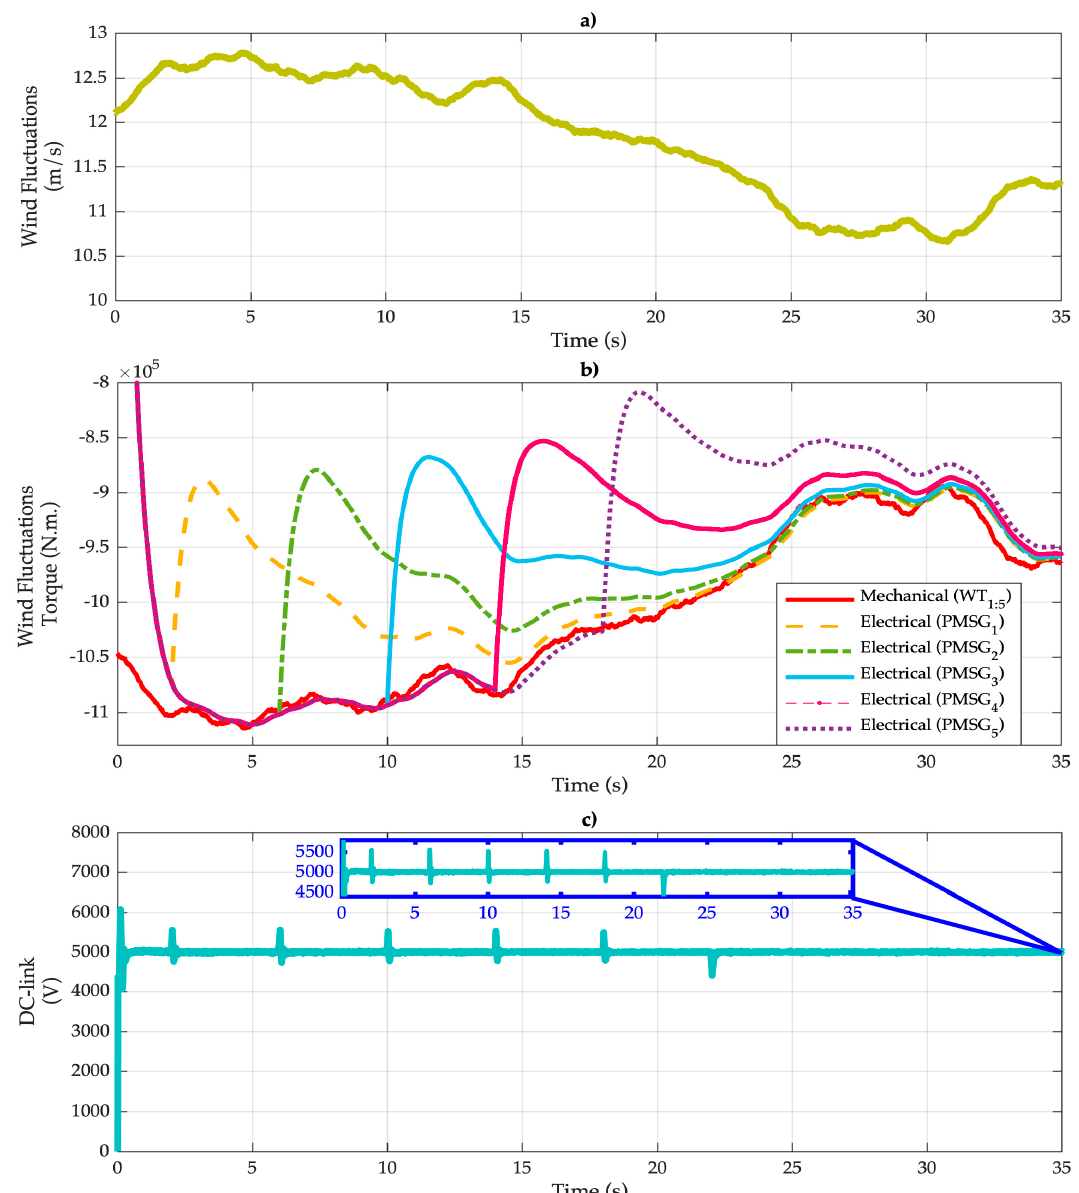
Figure 7. Behavior of parameters in the WECS in a closed loop. ( a ) Wind fluctuations; ( b ) mechanical and electrical torque; ( c ) DC-link